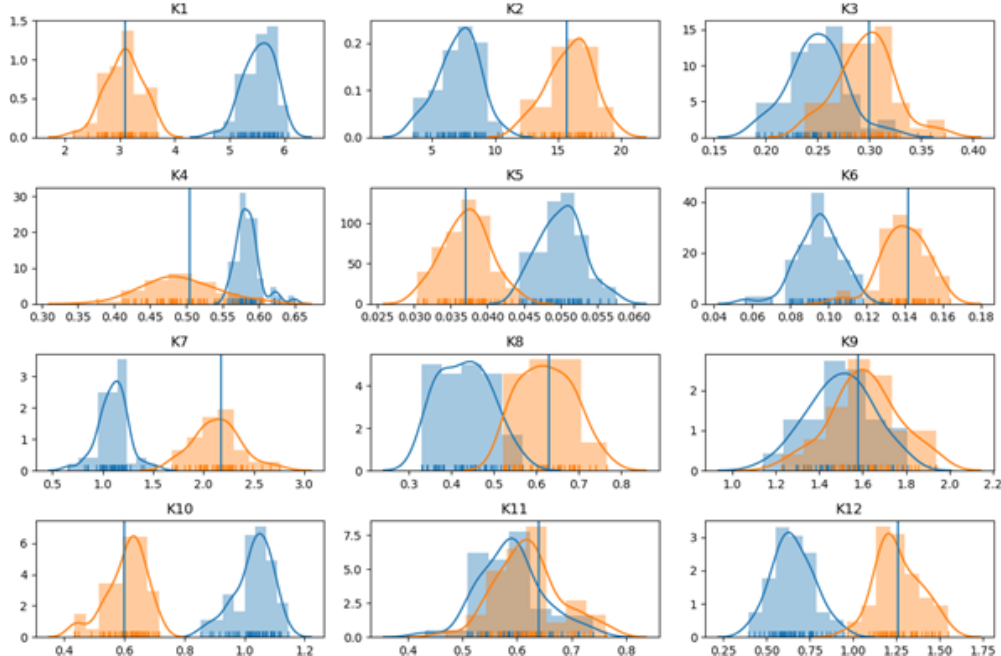
Figure 10. Prior and posterior PTF constant value distributions. Orange shows prior and blue posterior. The blue line shows the original value of the constant as in Table